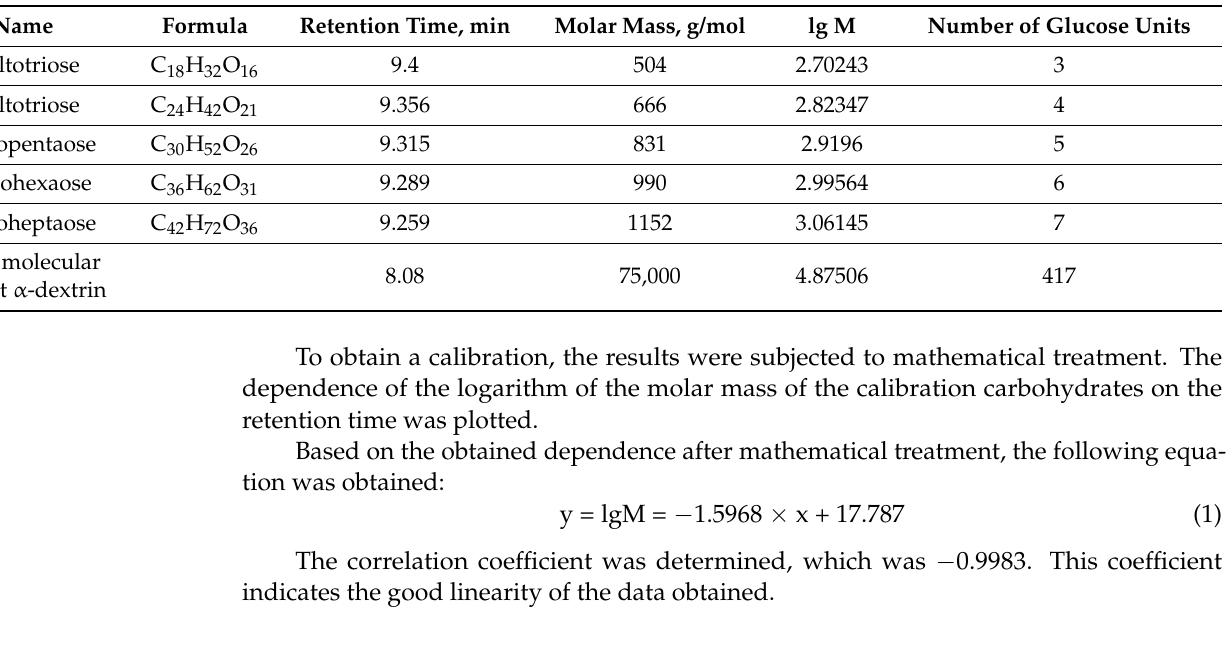
Table 1. Properties of α -dextrins used as standards in calibrations to determine the molar masses of the catalytic reactions